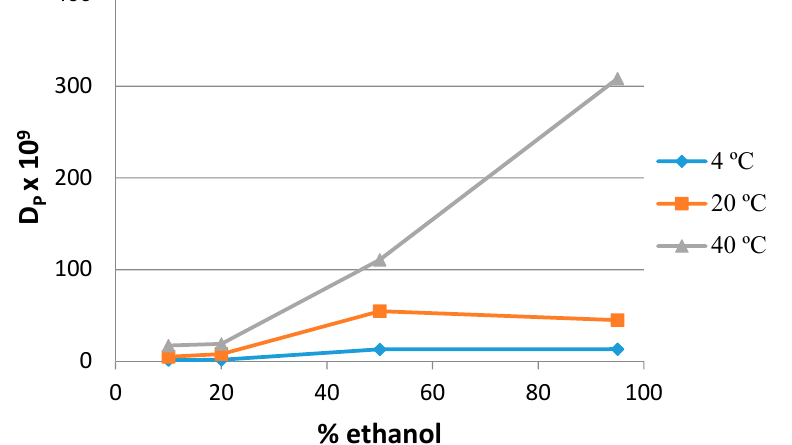
Figure 2. Relation between the 4-methyl benzophenone (4-MBP) di ff usion coe ffi cient ( D P ) and the percentage of ethanol of the food simulant.